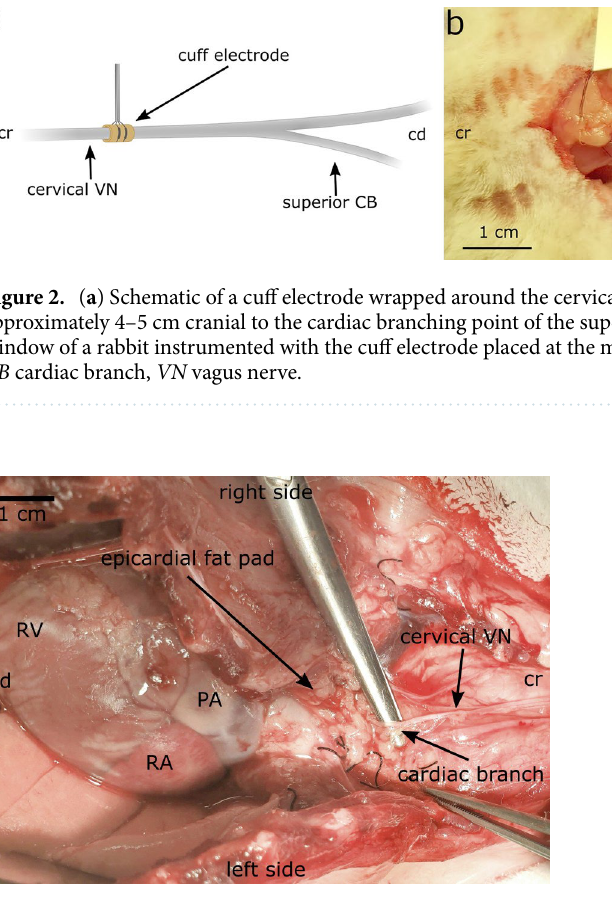
Figure 3. Surgical dissection of the vagus nerve (VN) for ex-vivo experiments including superior cardiac branch (CB). Here, the VN is shown from its caudal half of the cervical level to caudal to the superior CB. The heart is exposed after opening of the pericardium. Cr cranial, cd caudal, PA pulmonary artery, RA right atrium, RV right